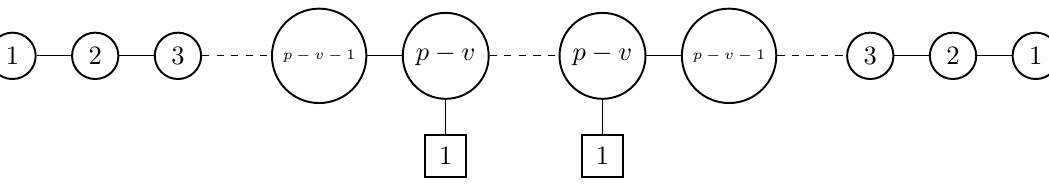
Figure 10 . This (cid:12)gure shows the brane con(cid:12)guration of (cid:12)gure 9 in a speci(cid:12)c Hanany-Witten frame where the D1-branes localized at the origin begin and end only on NS5 branes. The number in red is the number of D1-branes in an interval between two NS5-branes.